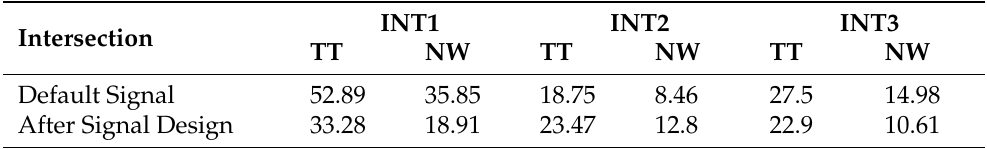
Table 5. The comparison of traffic measurements (i.e., travel time (TT), normalized waiting time (NWT)) before and after signal design and